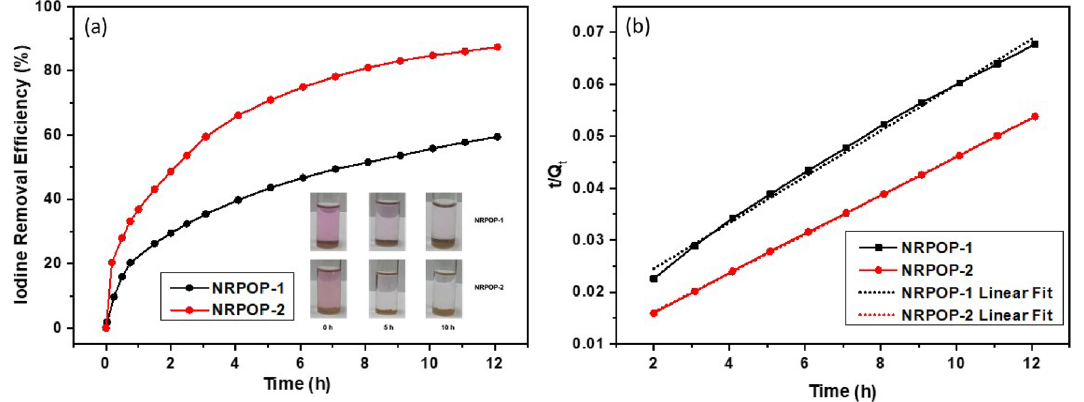
Figure 5. Iodine percentage removal from 300 mg L −1 iodine solution of cyclohexane by NRPOPs; Inset: photographs showing solutions color change after immersing NRPOPs into the solutions ( a ); pseudo-second- order kinetic fitting for iodine adsorption experimental data ( b ).